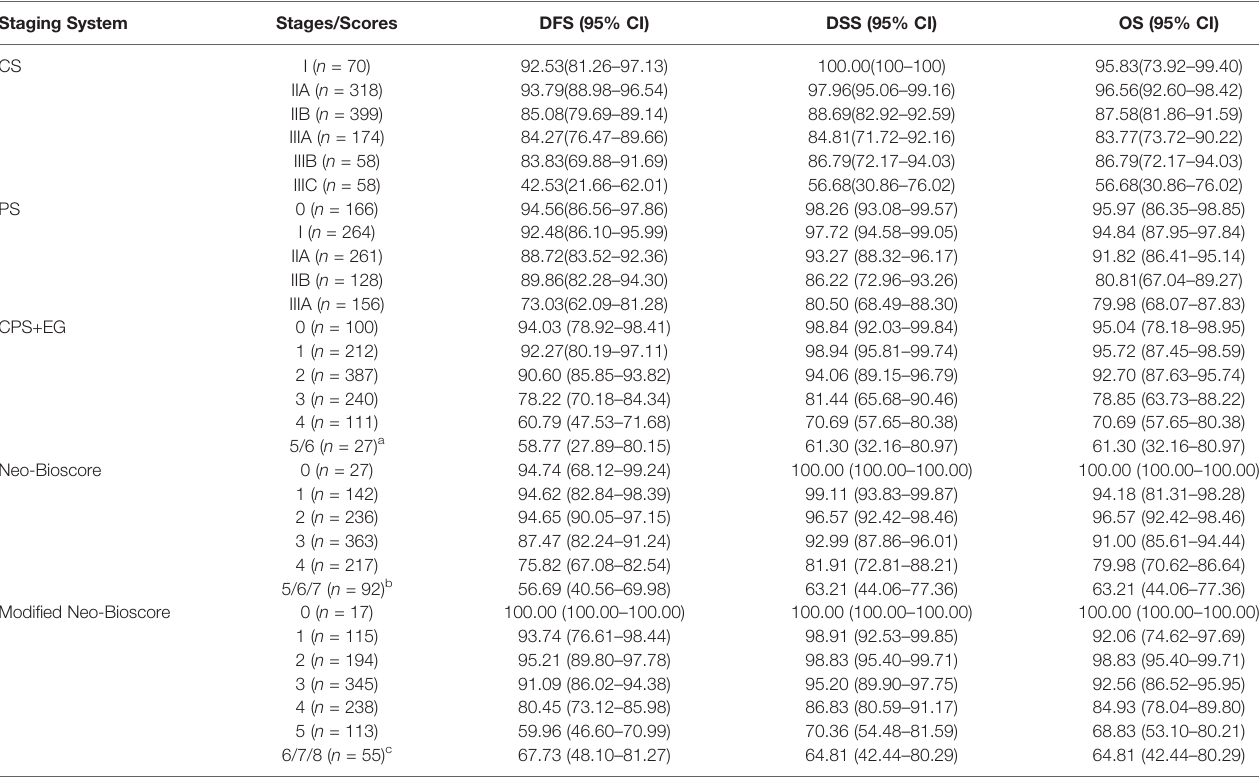
CS,pretreatmentclinicalstage;PS,post-treatmentpathologicalstage;CPS+EG,clinical-pathologicstagingsystemincorporatingestrogenreceptor-negativediseaseandnucleargrade3 tumor pathology; DFS, disease free survival; DSS, disease speci fi c survival; OS overall survival. DFS, DSS, and OS were calculated by K-M method. a scores 5 and 6 of CPS + EG were combined because of small number patients; b scores 5, 6, and 7 of Neo-Bioscore were combined because of small number patients; c scores 6, 7, and 8 of modi fi ed Neo-Bioscore were combined because of small number patients.